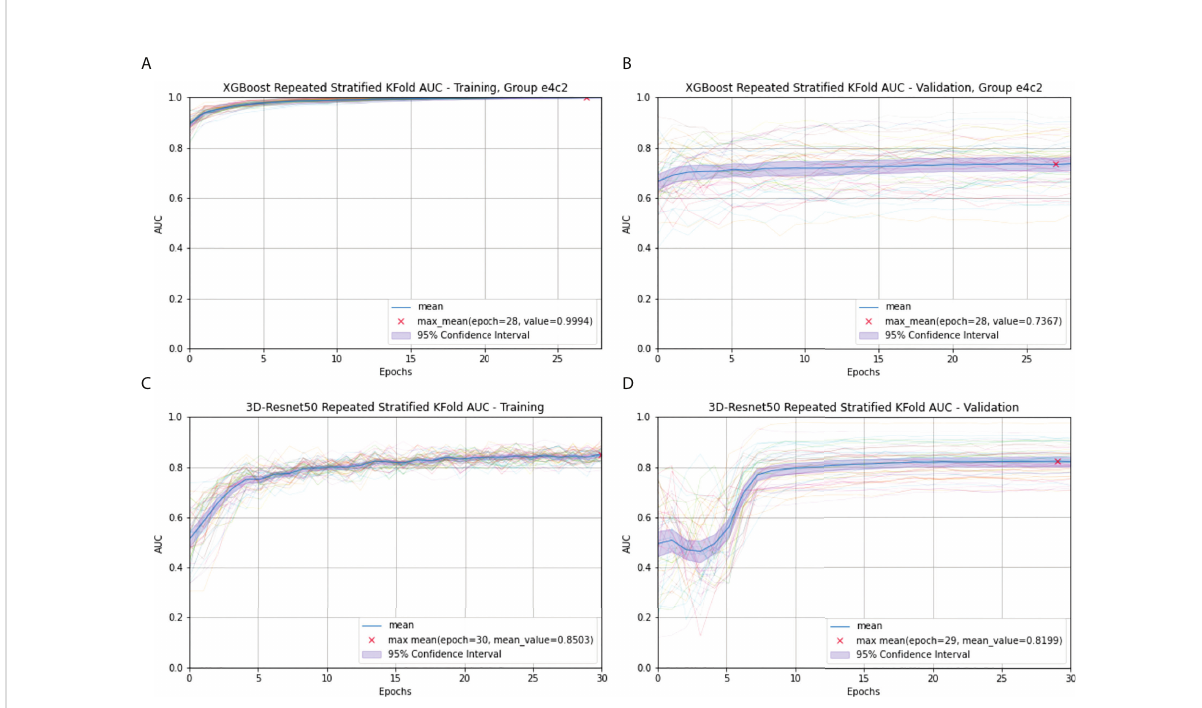
FIGURE 4 Radiomics (A) and 3D-Resnet-50 (C) Repeated Strati fi ed 5-Fold AUC in the training cohort; Radiomics (B) and 3D-Resnet-50 (D) Repeated Strati fi ed 5-Fold AUC in the validation cohort. The epochs are depicted on the x -axis, each representing the process of training all training samples once. The thick blue curve represents the mean AUC value. The blue area represents the 95% con fi dence interval (CI). The red fork represents the maximum mean of the AUC value after repeating multiple epochs.